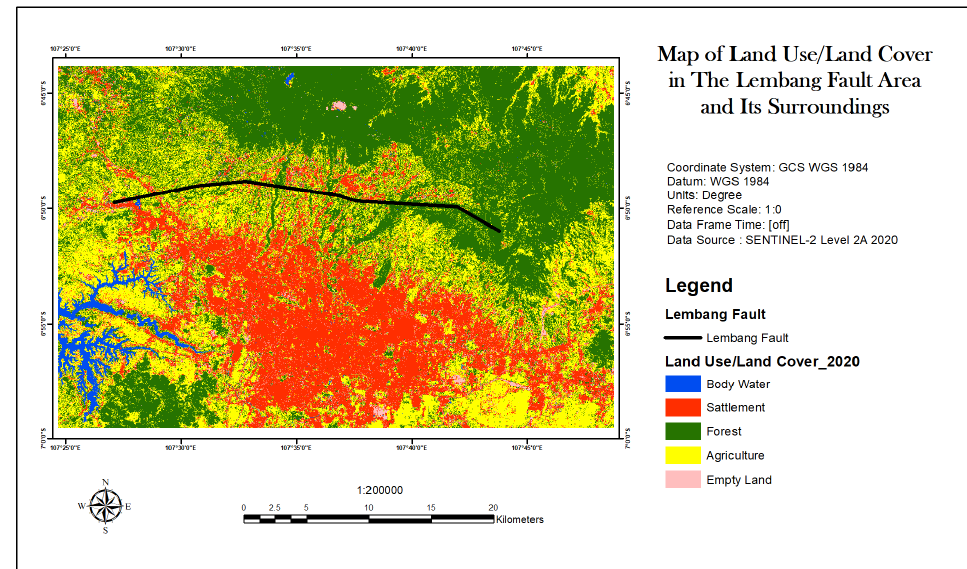
Figure 2. Land use/land cover of Lembang Fault in 2019. In 2019, the land use/land cover of the Lembang Fault area was dominated by forest (44.55%) and agricultural land (30.60%). Settlement areas coverage was 22.80%.